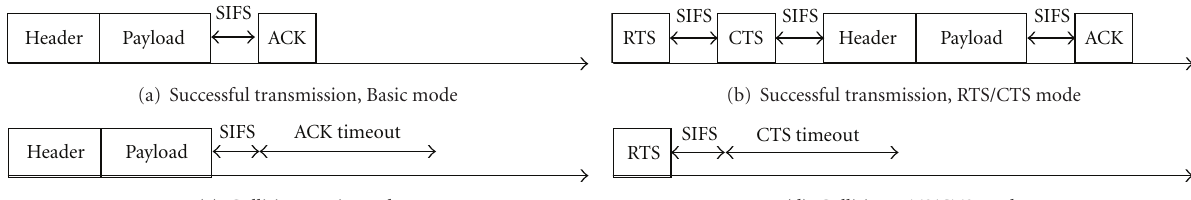
Figure 6: Transmission time for one data frame.